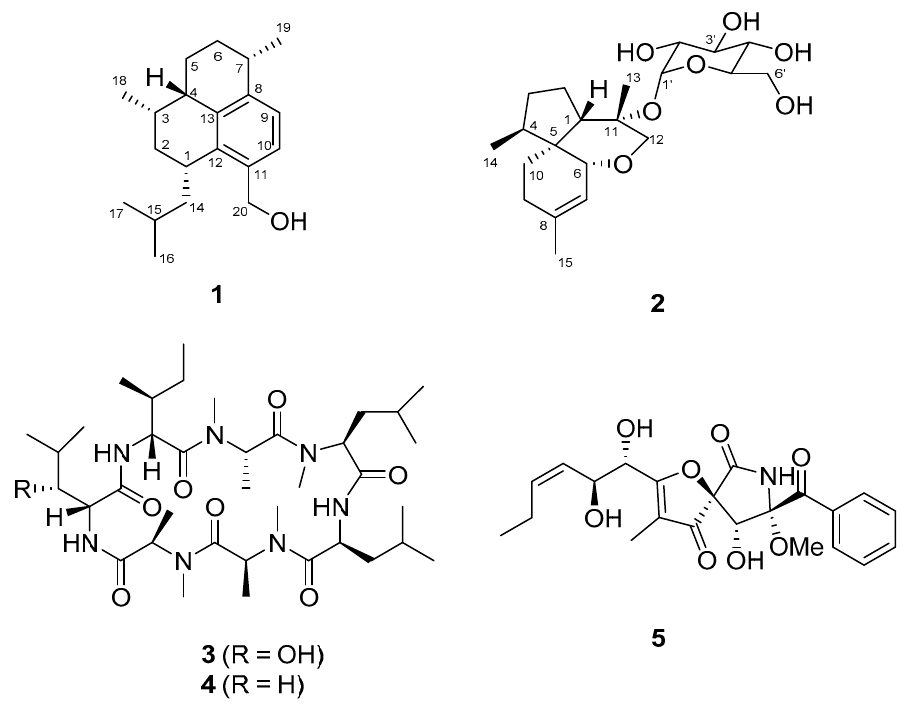
Figure 1. Chemical structures of compounds 1 – 5 .